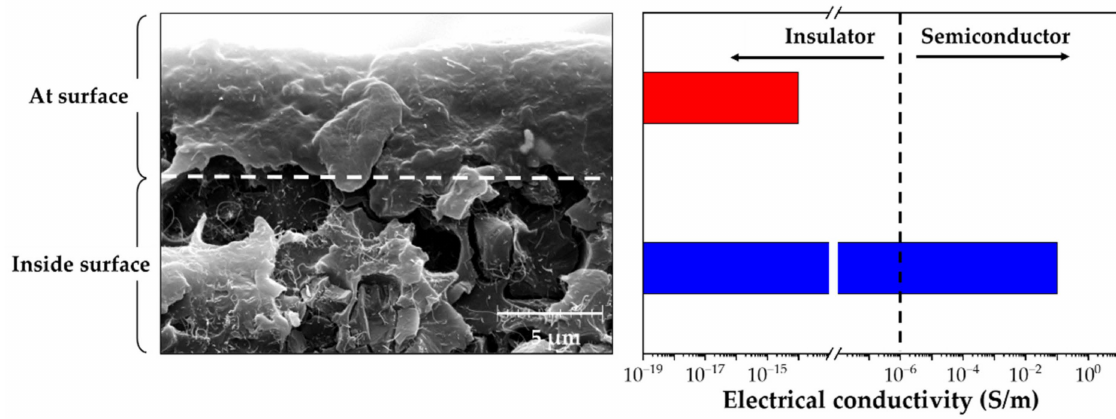
Figure 4. SEM image of a cross-section of the CNT/EP coating with electrical